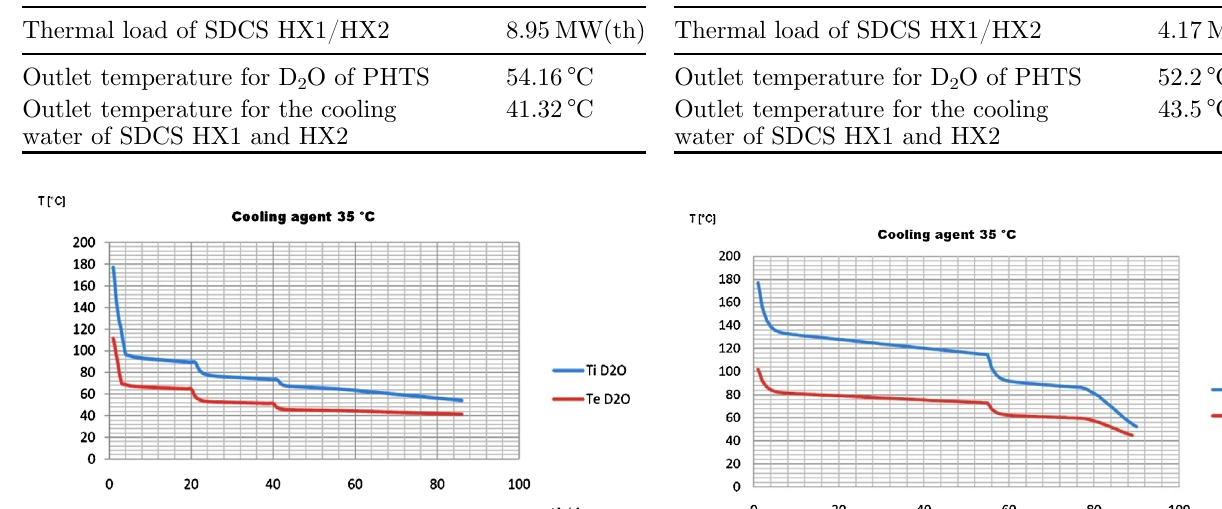
Table 7. Thermal analysis. Model VI.